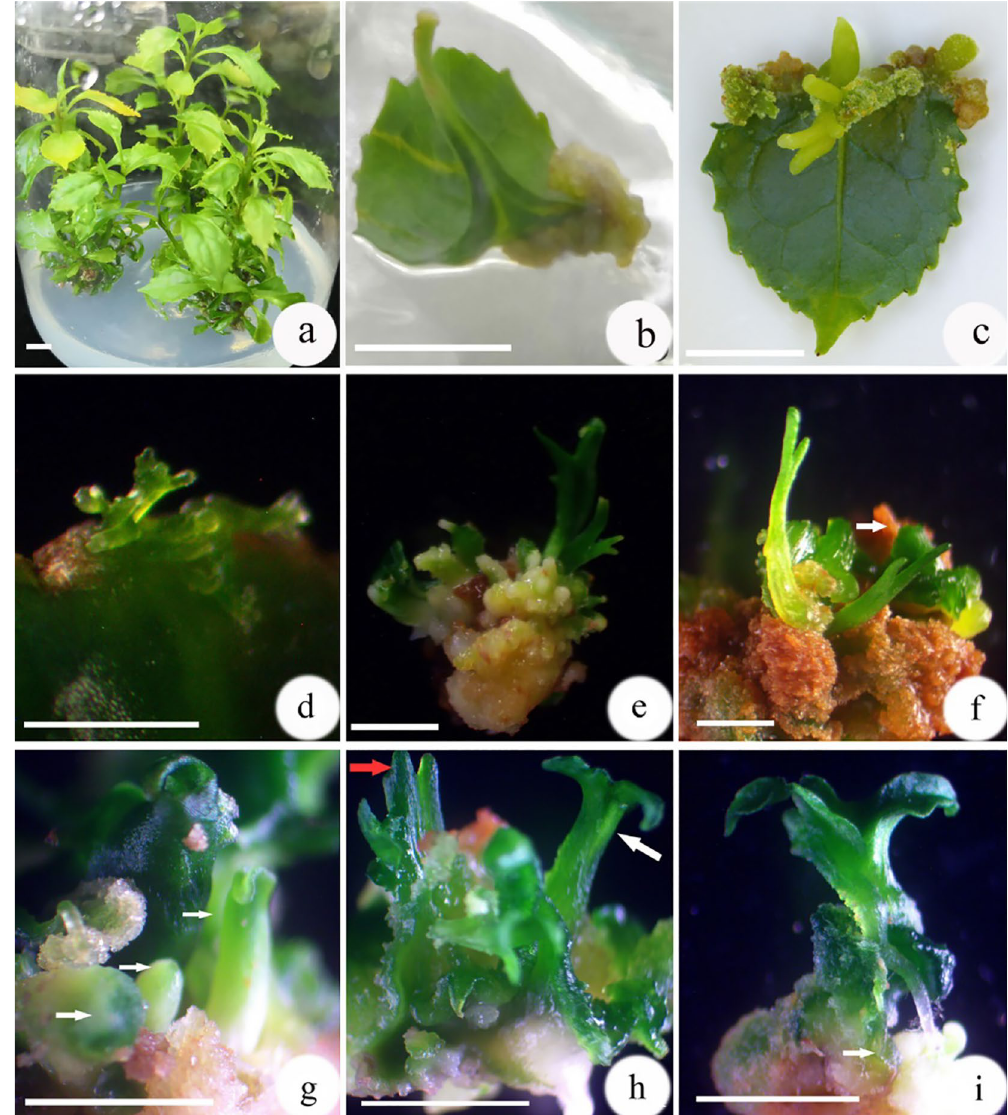
Figure 1. Shoot organogenesis from leaf explants in Euryodendron excelsum . ( a ) Leaf explants derived from axillary shoots on PGR-free WPM for 4 weeks. ( b ) Callus was induced on WPM with 1.0 mg/L 2,4-D after culture for 6 weeks. ( c ) Callus and adventitious roots were induced on WPM with 1.0 mg/L NAA after culture for 6 weeks. ( d ) Adventitious shoots were induced on WPM with 1.0 mg/L TDZ and 0.2 mg/L NAA after culture for 6 weeks. ( e ) Callus induced on WPM with 1.0 mg/L 2,4-D cultured for 6 weeks, then they were transferred to on WPM with 1.0 mg/L BA and 0.2 mg/L NAA for an additional 3 weeks, the callus differentiated into adventitious shoots. ( f ) Callus induced on WPM with 1.0 mg/L 2,4-D cultured for 6 weeks, then differentiated into adventitious shoots (white arrow) on PGR-free WPM after 21 d. ( g ) Callus induced on WPM with 1.0 mg/L 2,4-D cultured for 6 weeks, then differentiated into globular and torpedo-shaped somatic embryos (white arrows) on PGR-free WPM for 4 weeks. ( h ) Callus induced on WPM with 1.0 mg/L 2,4-D after culture for 6 weeks, then differentiated into adventitious shoots (red arrow) and somatic embryos (white arrows) on PGR-free ½WPM for 4 weeks. ( i ) Callus induced on WPM with 1.0 mg/L 2,4-D after culture for 6 weeks, then differentiated into cotyledon-shaped somatic embryo-like structure that developed roots on PGR-free WPM after 4 weeks. Bars = 1.0